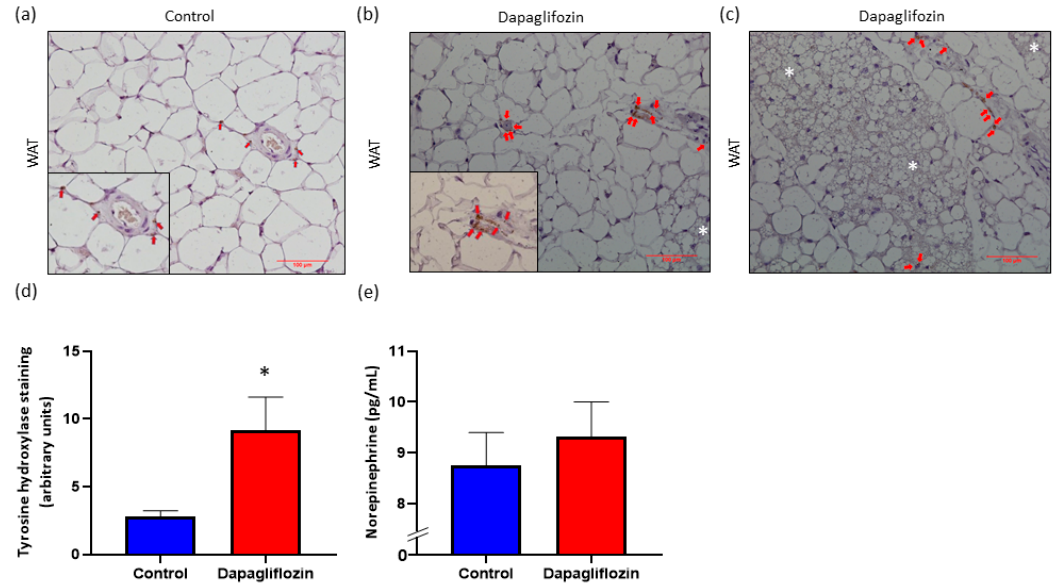
Figure 4. SGLT2 inhibition promotes increased SNS innervation in WAT. ( a – c ) Representative immunohistochemistry images of tyrosine hydroxylase expression in WAT. Tyrosine hydroxylase staining is brown in color and is indicated with arrows. Insets indicate close-ups of TH staining. Size bar = 100 μ m. Magnification 200×. Brown adipose tissue like morphology is indicated with a white asterisk. ( d ) Quantitation of tyrosine hydroxylase expression in WAT from BPH/2J mice; n = 9–11 mice/group. * p = 0.011. ( e ) Norepinephrine in WAT from BPH/2J mice; n = 7–8 mice/group. All data are presented as mean ± SEM.